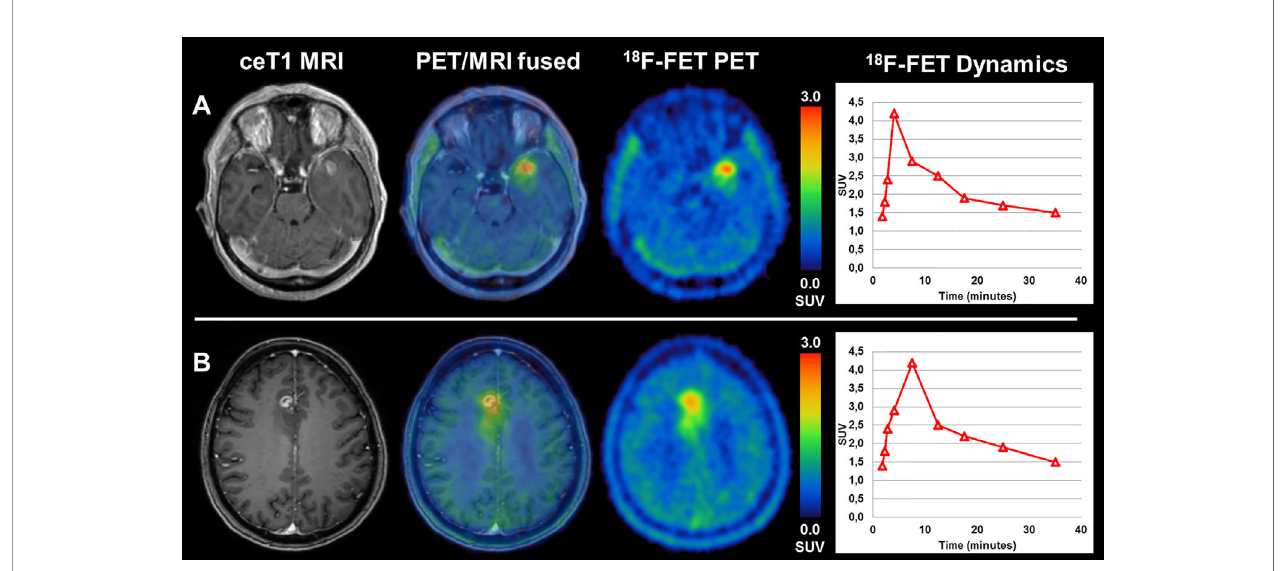
FIGURE 1 | (A) a patient with TERTp-mutant glioblastoma (TBR max 4,1; TBR mean 2,3; BTV 15,4 ml, TTP min 5 min ) shows comparable, only slightly diverging imaging features as (B) , a patient with TERTp-wildtype glioblastoma (TBR max 2,9; TBR mean 1,9; BTV 12,3 ml, TTP min 10 min ).